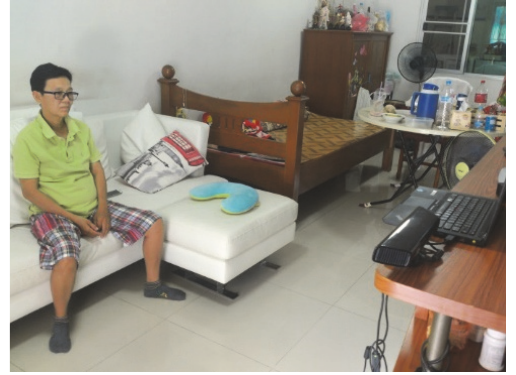
Figure 9: Experiment setup for post-fall intelligence system